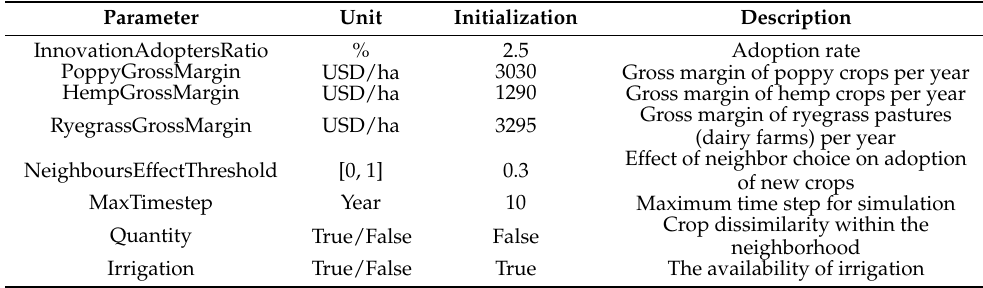
Table A1. Parameters used to initialise the Crop GIS-ABM in a scenario analysis that examined the adoption of alternative crops and the introduction of irrigation